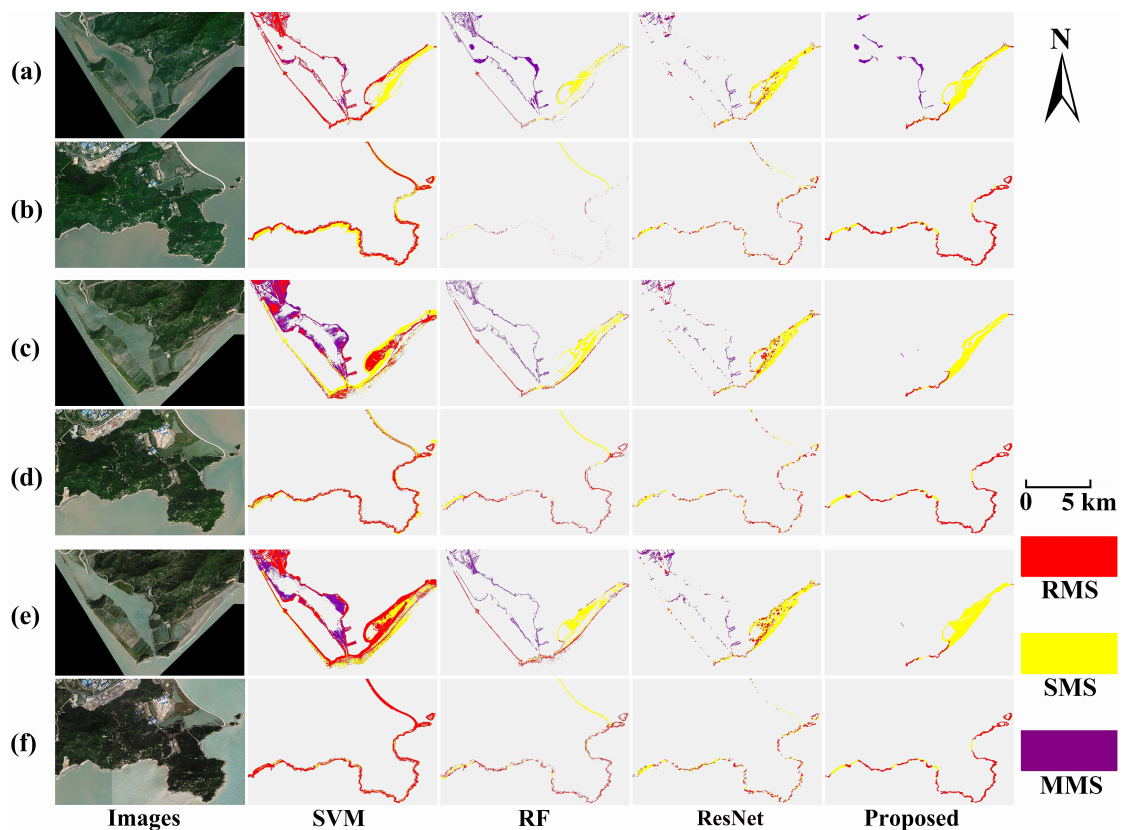
Figure 15. Comparison of results with other methods: ( a ) results of Image 1 in 2015; ( b ) results of Image 2 in 2015; ( c ) results of Image 1 in 2017; ( d ) results of Image 2 in 2017; ( e ) results of Image 1 in 2018; ( f ) results of Image 2 in